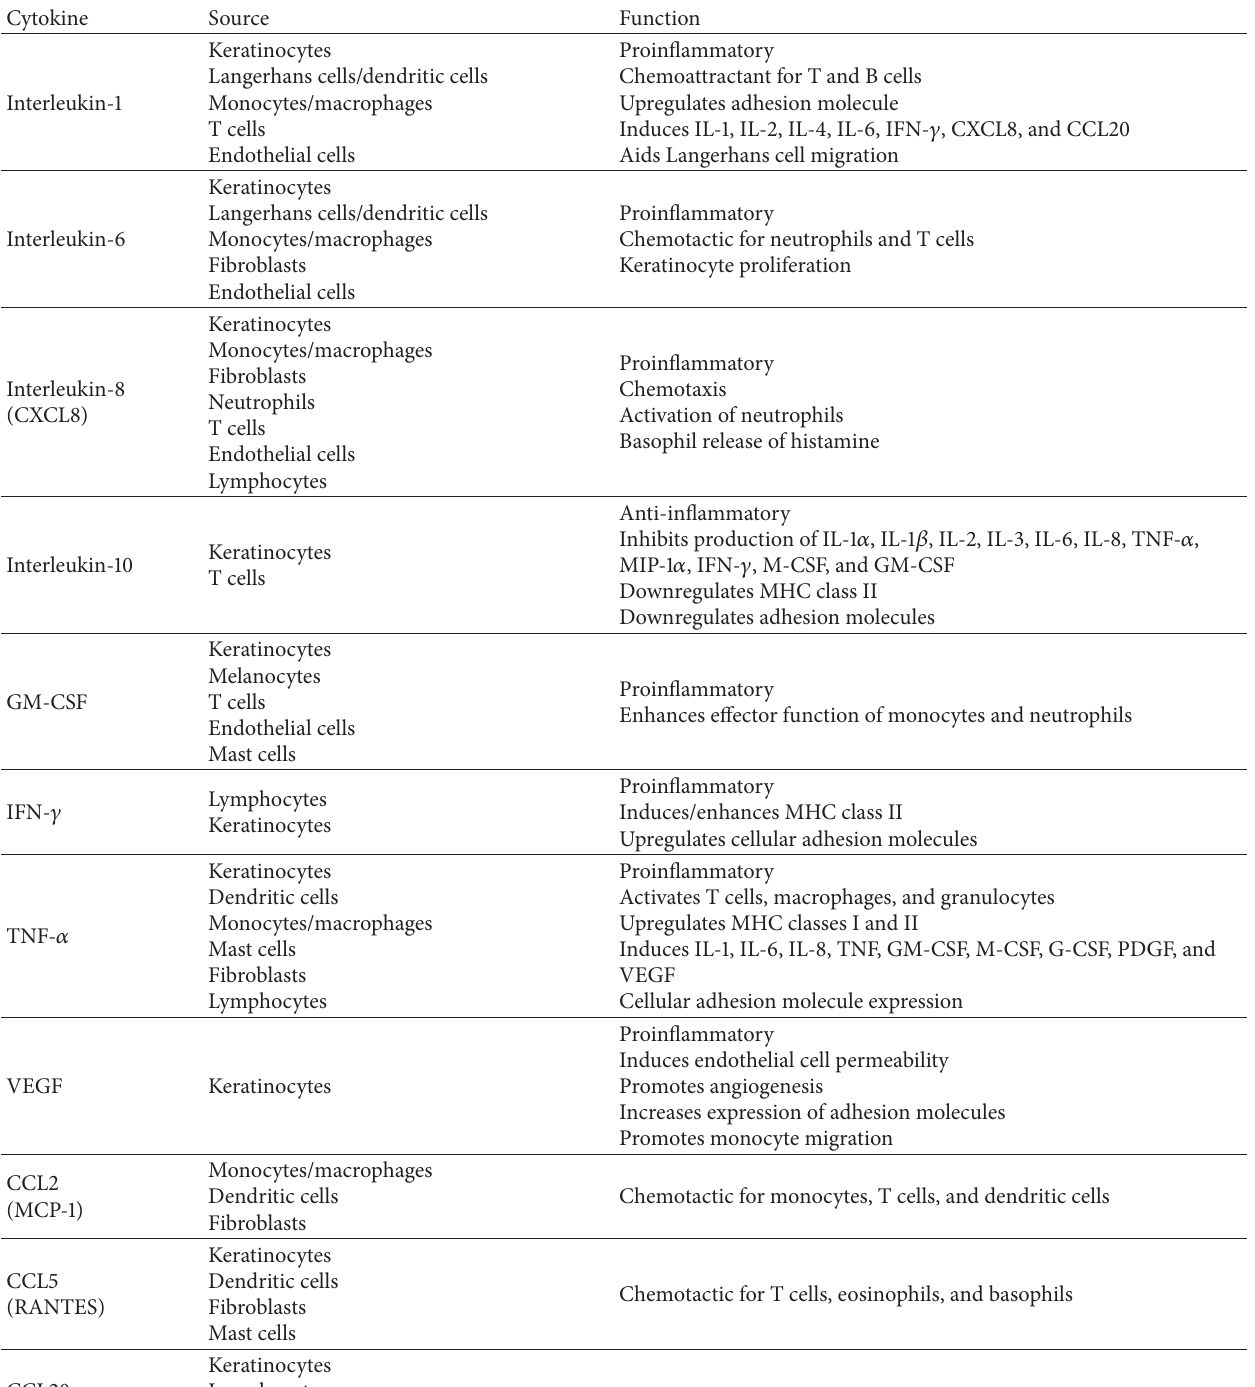
Table 1: Key cytokines and chemokines involved in